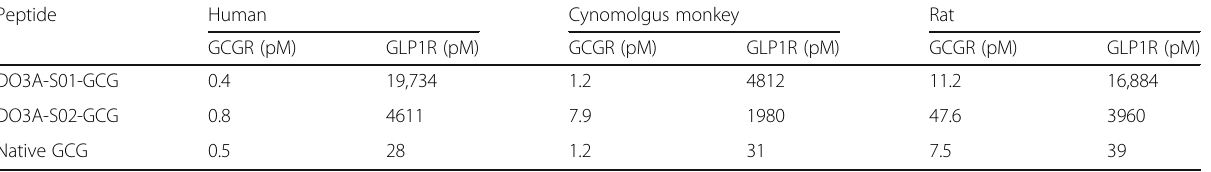
All values are EC 50 given as